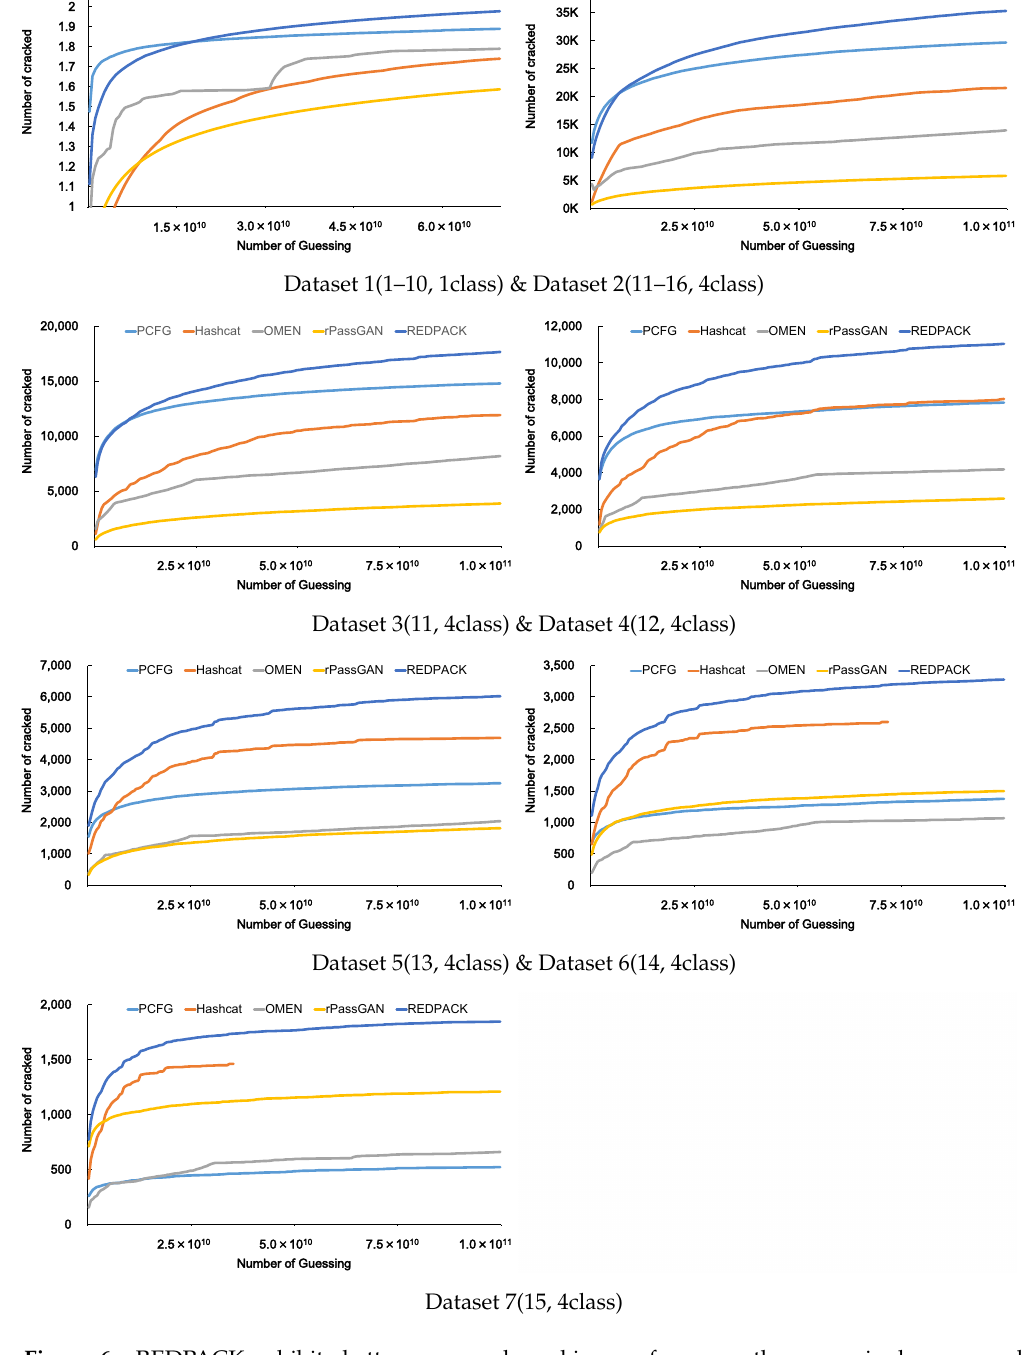
Figure 6. REDPACK exhibits better password cracking performance than any single password generation